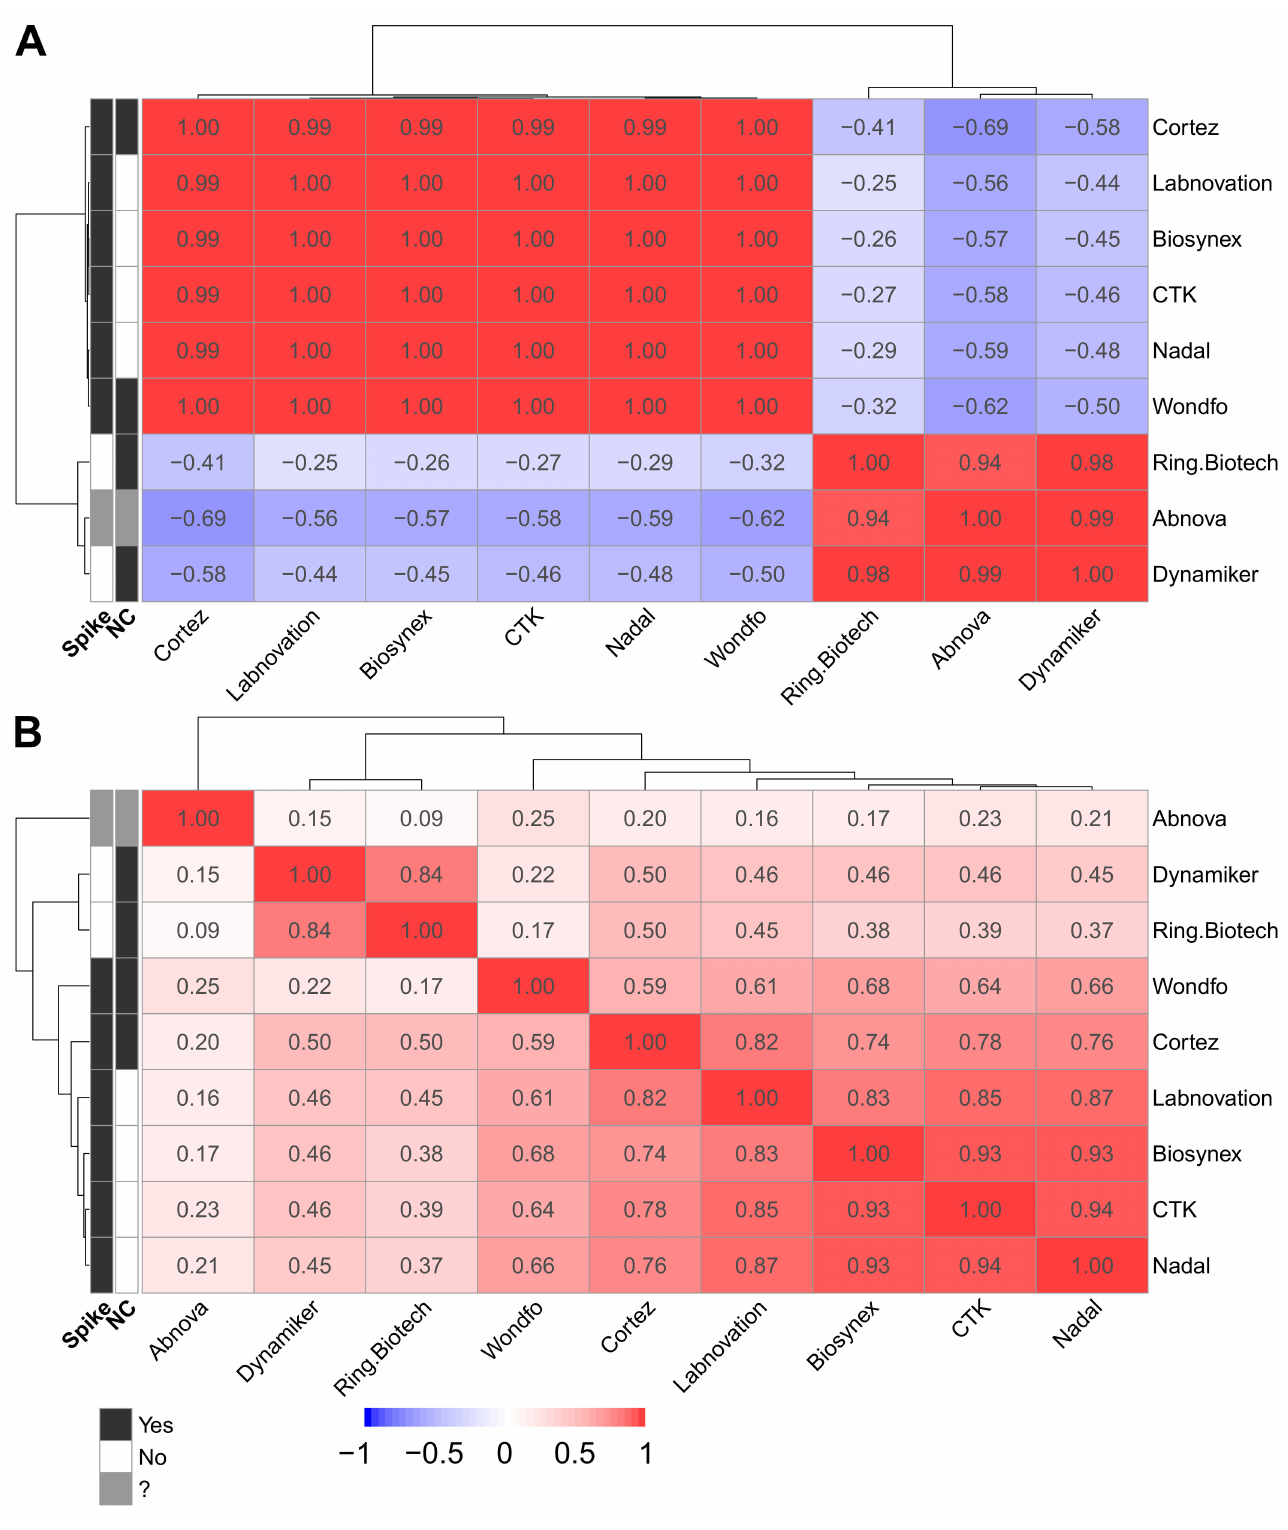
Figure 3. ( A ) Correlation heat map of anti-spike IgG and LFA results sorted by LFA and antigen. Clustering of spike-protein-containing LFAs and exclusively nucleocapsid-containing LFAs can be seen. The LFA from Abnova clusters with the nucleocapsid protein-containing assays. ( B ) Correlation heat map of anti-spike IgG and LFA results sorted by LFA. The output of the regression models used can be found in the Supplementary